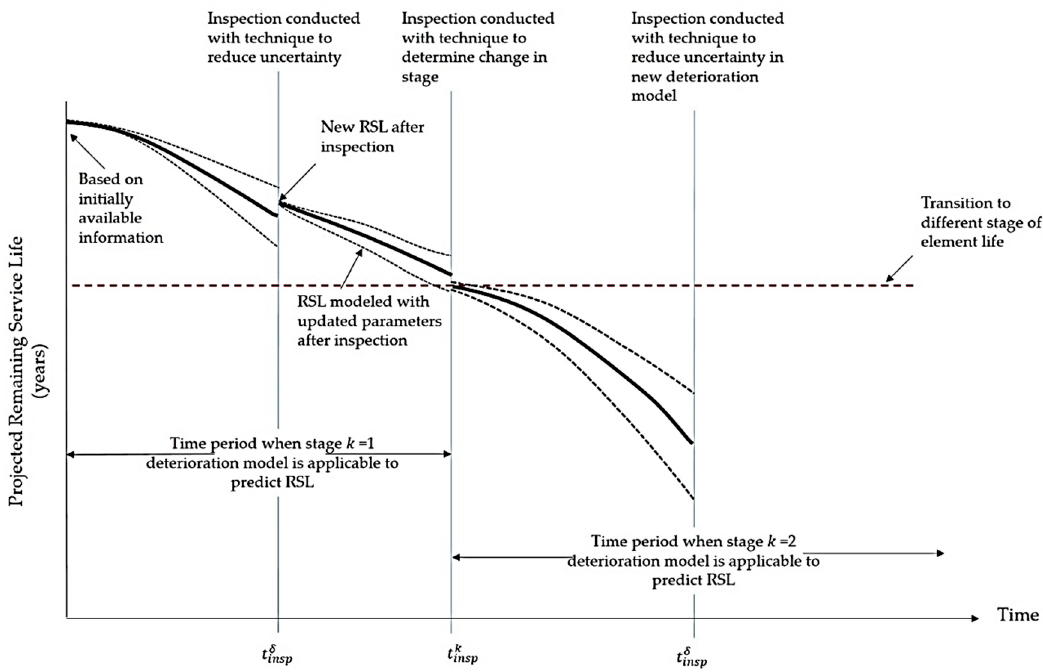
Figure 3. An example implementation of the uncertainty-based inspection planning (The solid lines in the figure represent the mean predicted RSL, while the dotted lines represent the uncertainty in the prediction).